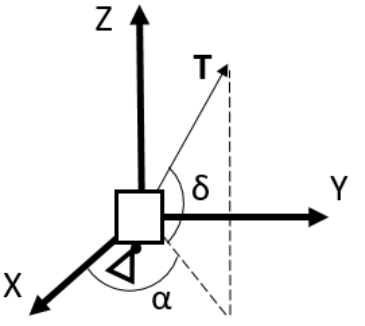
Figure 4. Ascension and declination of the thrust